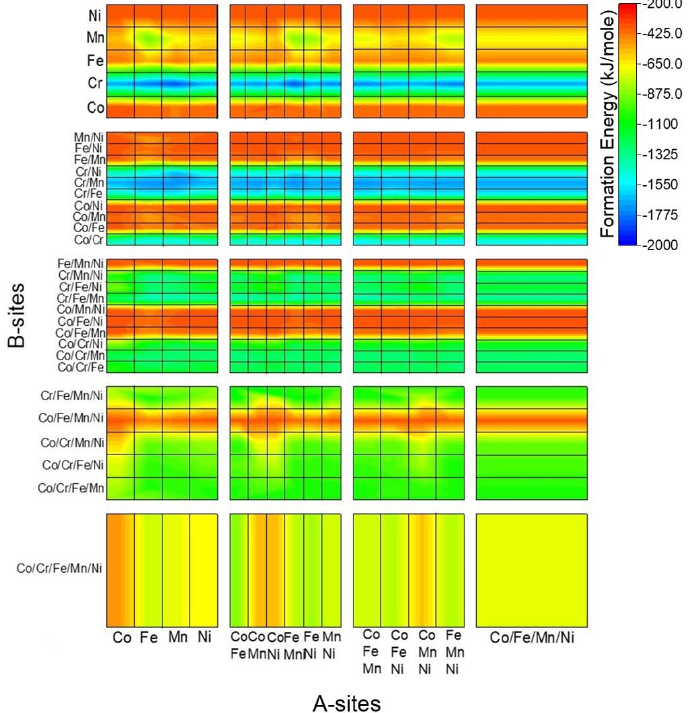
Figure 4. The predicted formation energies of the spinel-structured HEOx with different metal cations in the A and B sites.